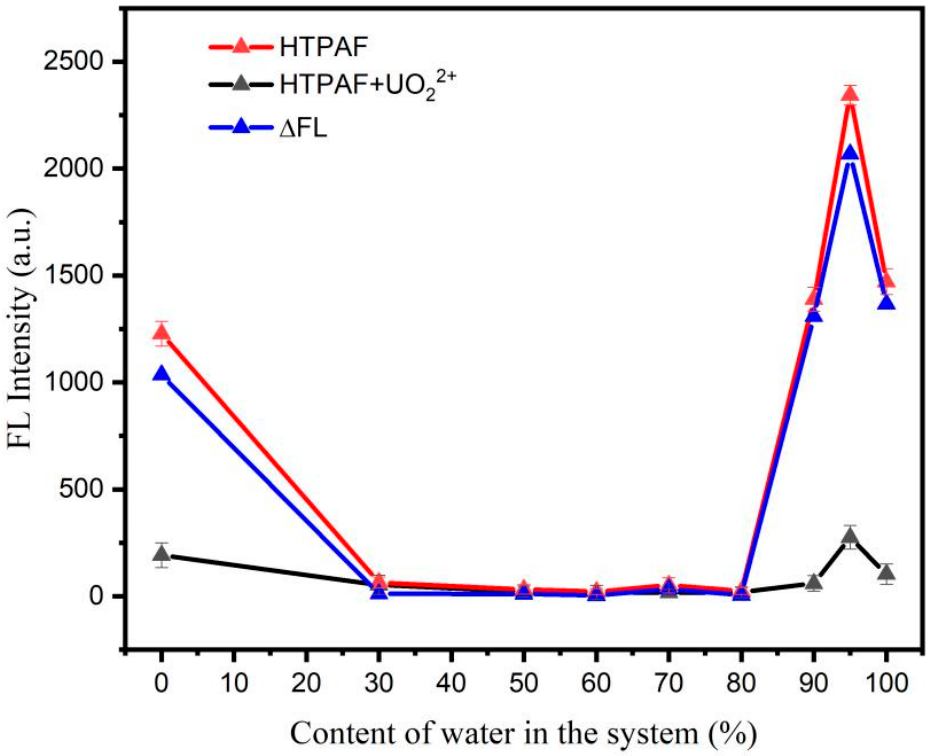
Figure 2. In the solvent system of DMSO:H 2 O, the fluorescence changes of HTPAF(50 µ M) fluorescent probe before and after adding UO 22+ under different water ratios.